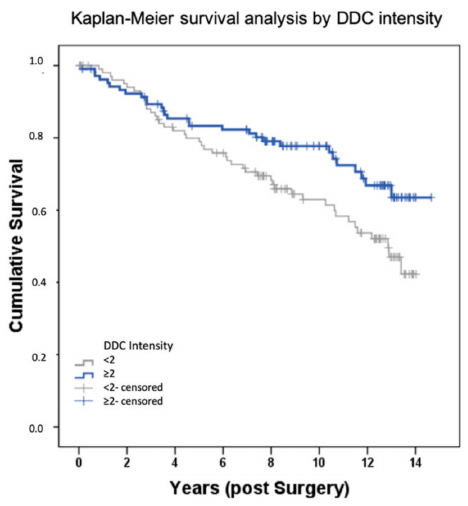
Figure 3. Influence of DDC expression on overall survival (OS) of patients with early breast cancer. Kaplan–Meier curve showing the association between an increased DDC expression (Intensity ≥ 2, n = 109; Intensity < 2, n = 126) and a longer overall survival ( p =